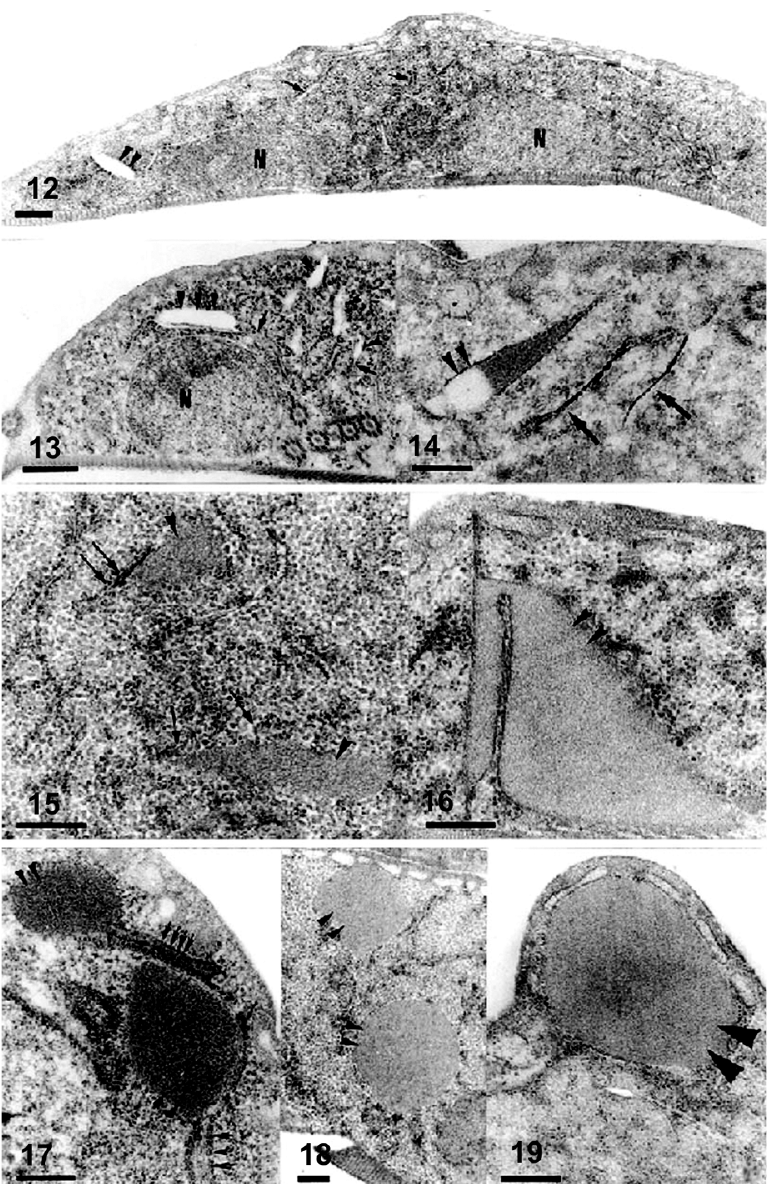
Figs. 12-19 – Different stages of the process of biosynthesis of cyst wall proteins during encystation of Giardia lamblia . The process starts with the formation of clefts in the endoplasmic reticulum (arrows in figure 12), accumulation of dense material within the clefts (arrows in Figs. 13-14), with the formation of encystation vesicles (Figs. 14-17) which then migrates towards the cell periphery (Figs. 17-19). N, nucleus. Bars, 0 . 4 µ m. After Lanfredi-Rangel et al. 2003.